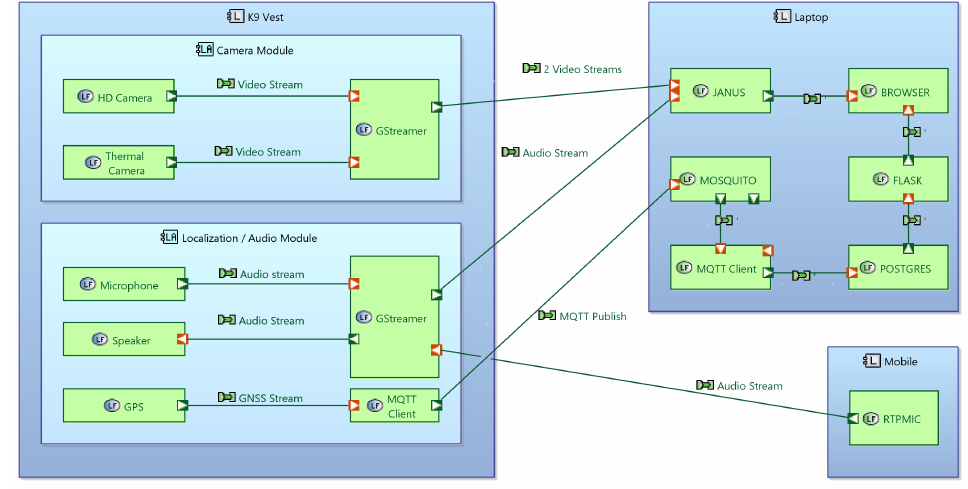
Figure 7. The K9 Vest inner